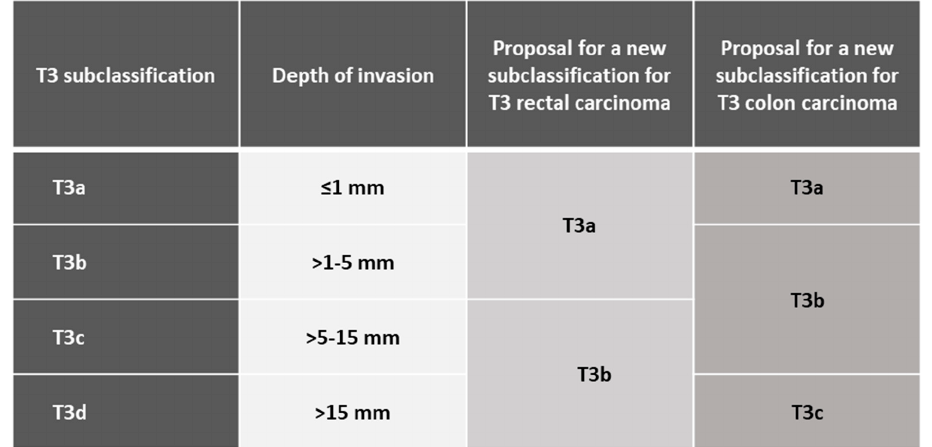
Table S3: Prognosis in patients with stage III with and without adjuvant chemotherapy (n =